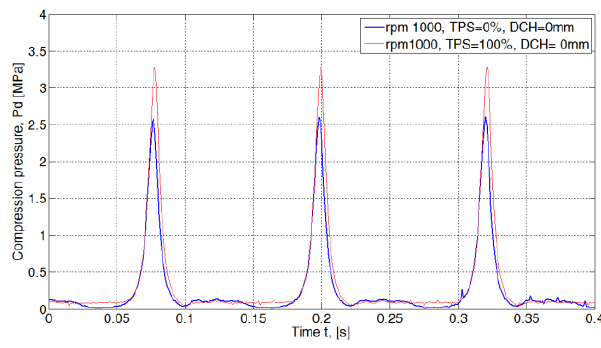
Fig. 6. Pressure curve in the combustion chamber with a closed channel for various throttle opening